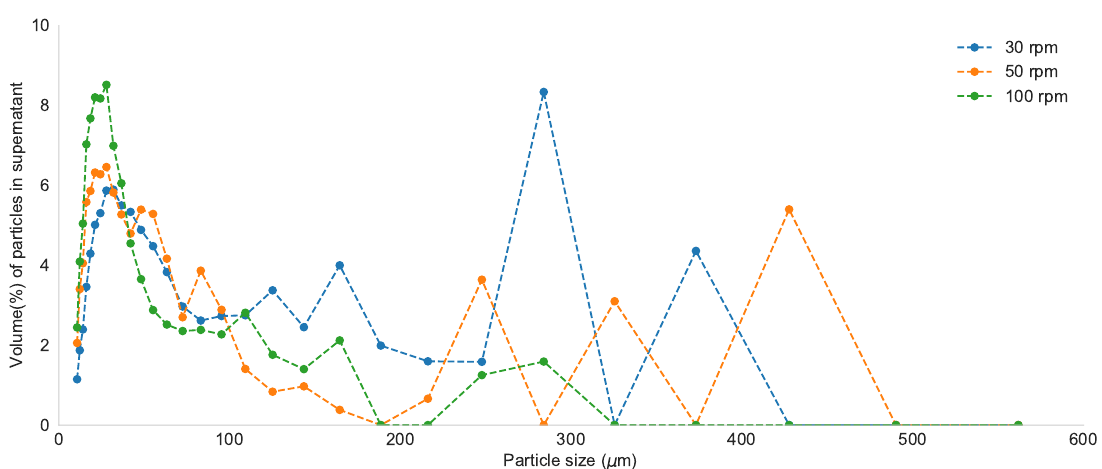
Figure A2. Volume based (in %) particle size distributions (PSDs) of the particles that stay behind in the supernatant after 30 min of settling, proceeded by 30 min of mixing (radial mixer) in a square jar with an impeller speed of 30 rpm, 50 rpm, or 100